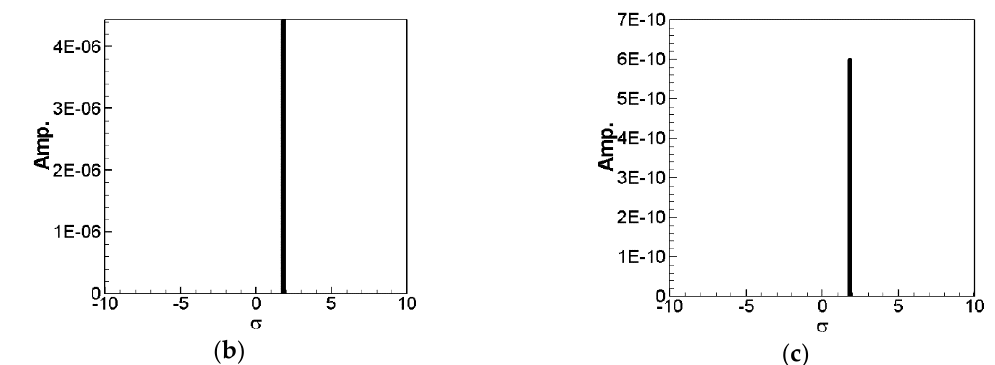
Figure 13. Fixed point plots when exciting the 2nd mode,( a ) 2nd mode Fixed point plot and time response,( b ) 1st mode Fixed point plot,( c ) 3rd mode Fixed point plot .